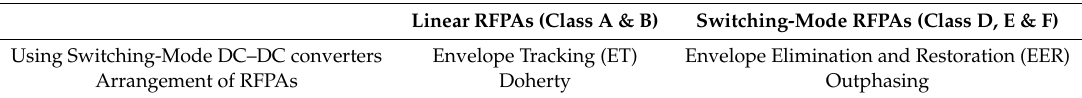
Table 1. Traditional techniques either to improve the e ffi ciency of or to linearize RFPAs.